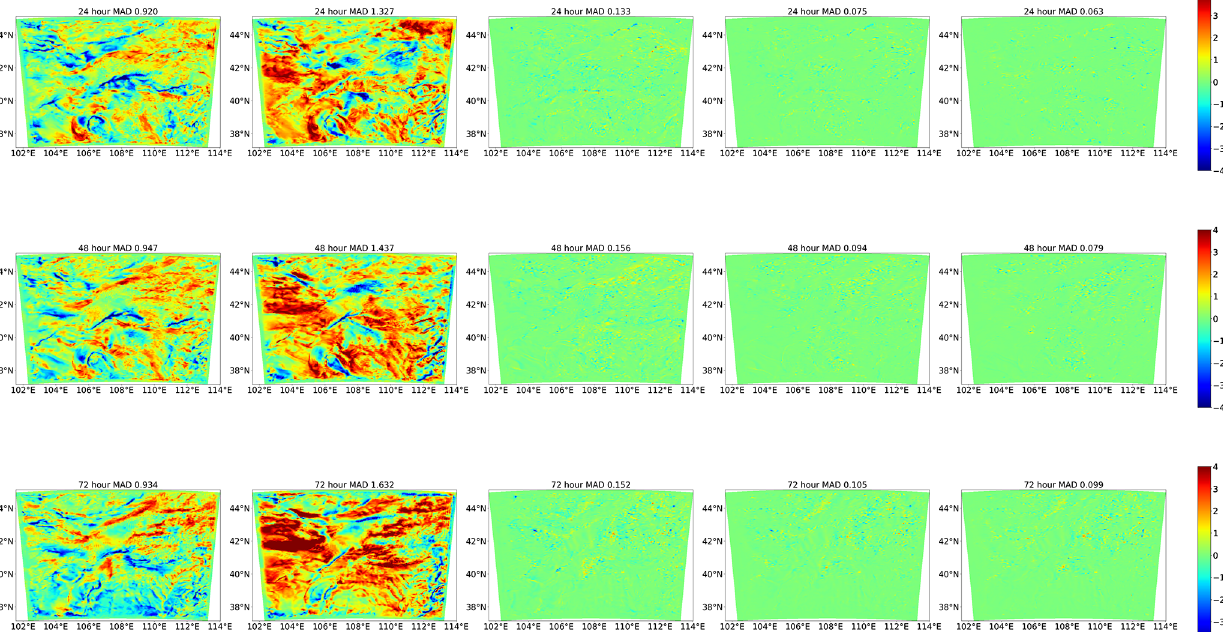
Figure 8. Differences in wind speed at 10m at forecast horizons of 24, 48, and 72h between WRF simulations coupled with ML models A, B, C, D, and E and the WRF simulation with the original RRTMG schemes for radiation